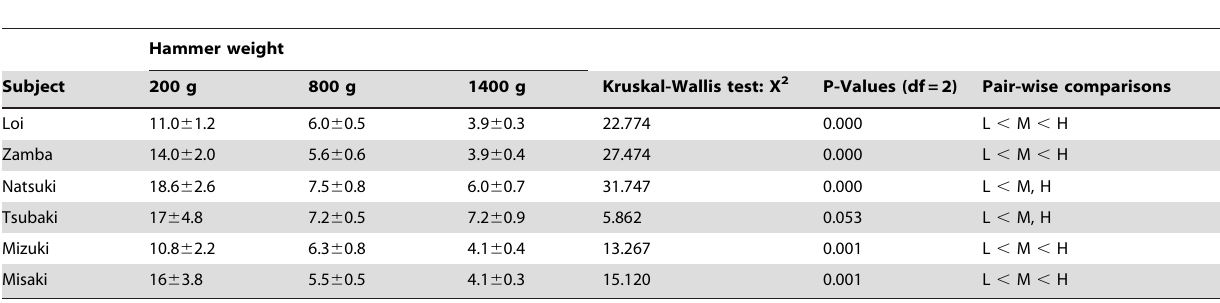
Table 7. Average number of strikes ( 6 SE) needed to solution for all subjects as a function of hammer weight in Experiment 3.